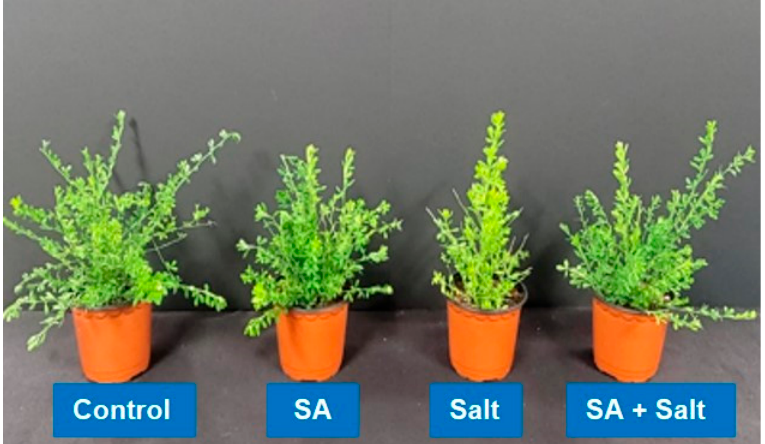
Figure 2. Morphological and physiological effect of salicylic acid on salinity-stressed St. John’s wort seedlings. St. John’s wort seedlings picture.